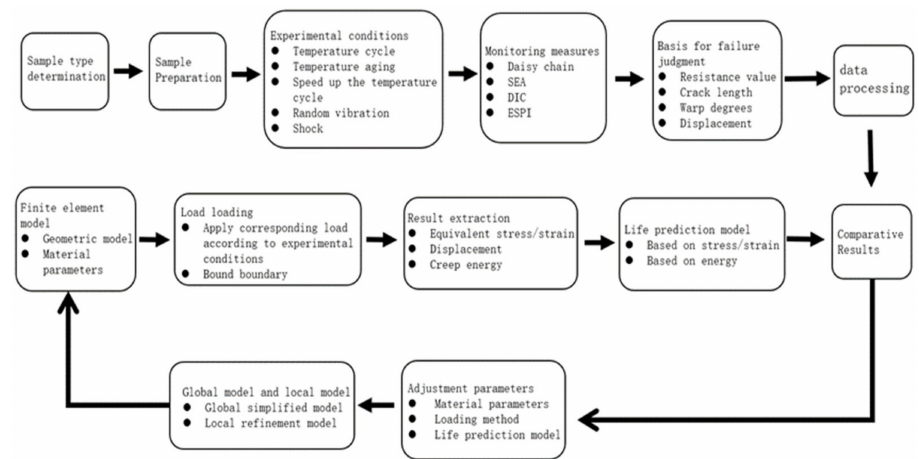
Figure 4. Combination of experimental studies and finite element